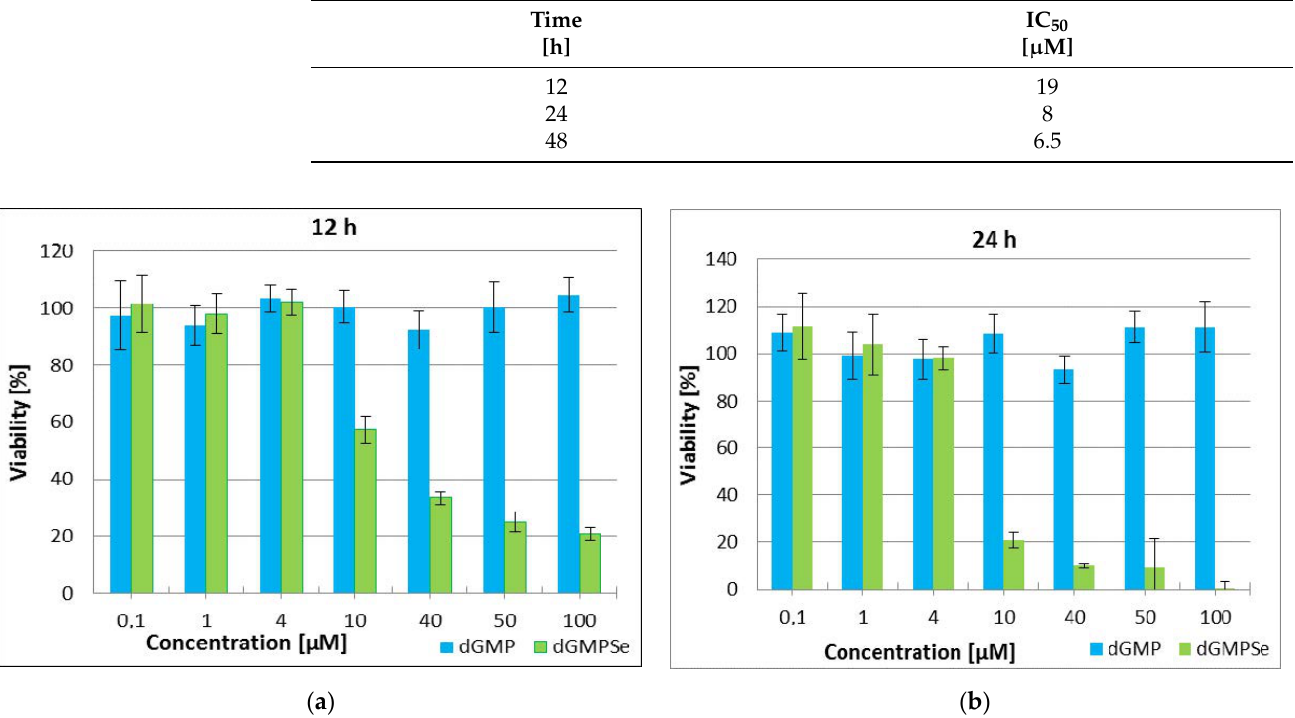
Figure 6. Viability of HeLa cells incubated with dGMPSe and dGMP after ( a ) 12 h, ( b ) 24 h, measured by MTT assay and expressed in %, where 100% means the growth level of cells not treated with any nucleotide.